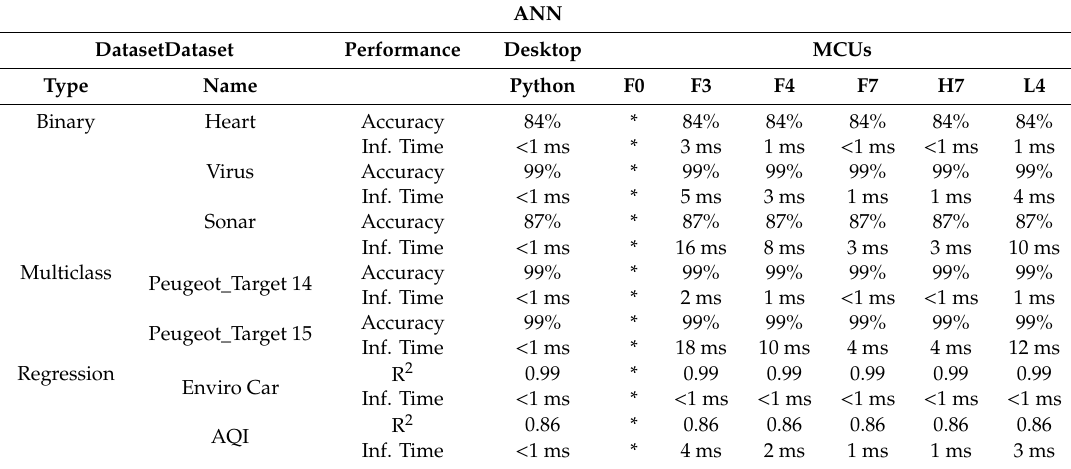
Table 6. Artificial Neural Network (ANN) performance.